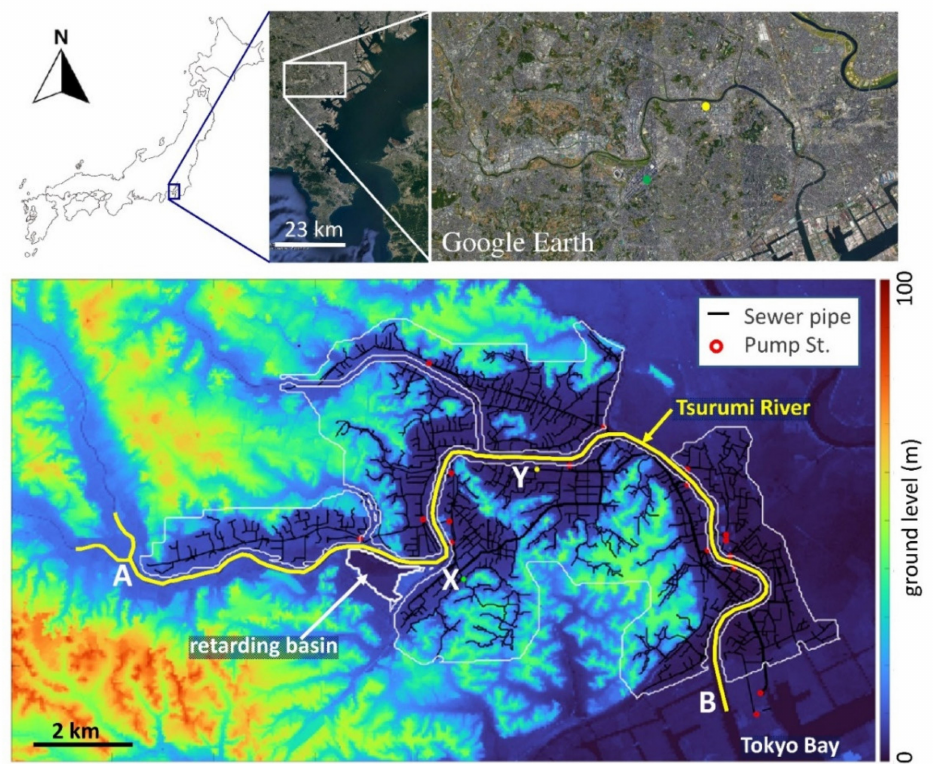
Figure 2. Locations and computational domain of the case study site, the Tsurumi River basin, Japan.